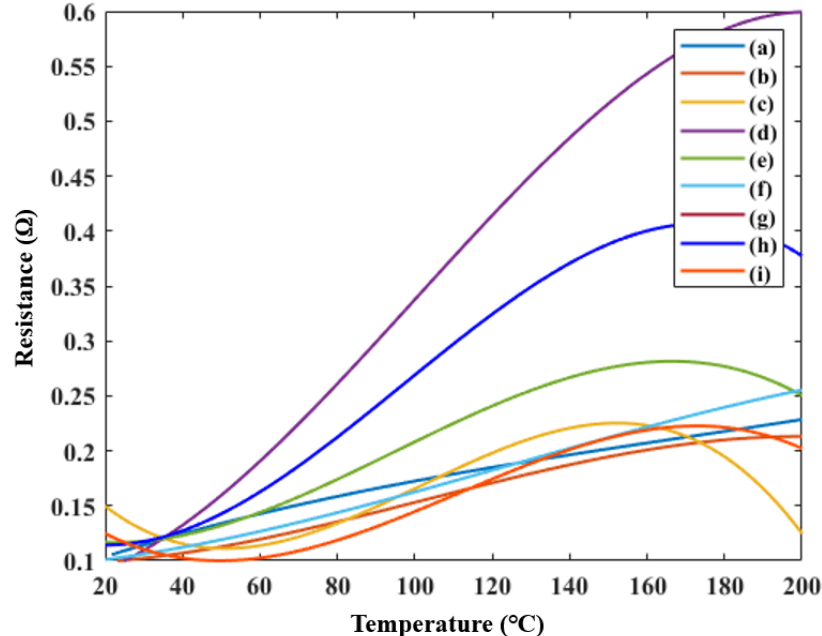
Figure 4. Resistances of the temperature-sensing inks with various material mixing ratios: ( a ) 100:100, ( b ) 100:150, ( c ) 100:200, ( d ) 150:100, ( e ) 150:150, ( f ) 150:200, ( g ) 200:100, ( h ) 200:150, and ( i ) 200:200 (nanoceramics:silver nanoparticles).